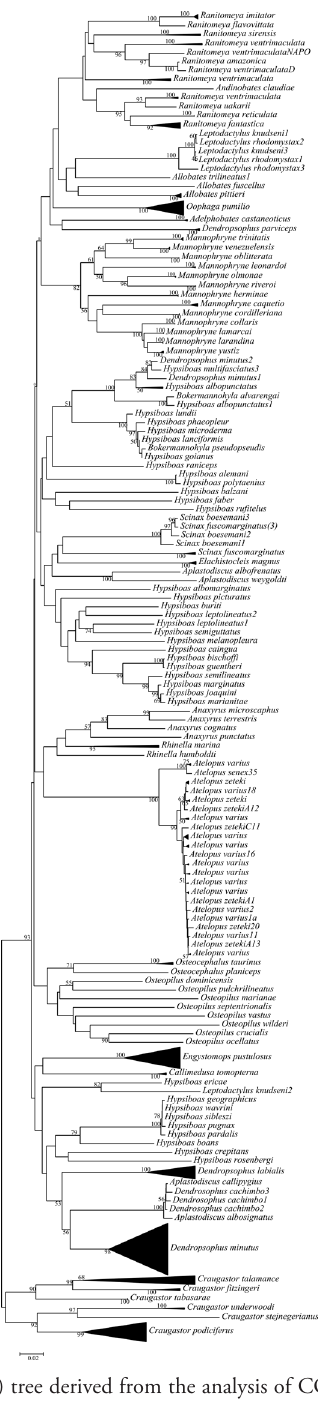
Figure 4. Neighbor-joining (NJ) tree derived from the analysis of COI sequences. The numbers at the nodes represent the percentage bootstrap